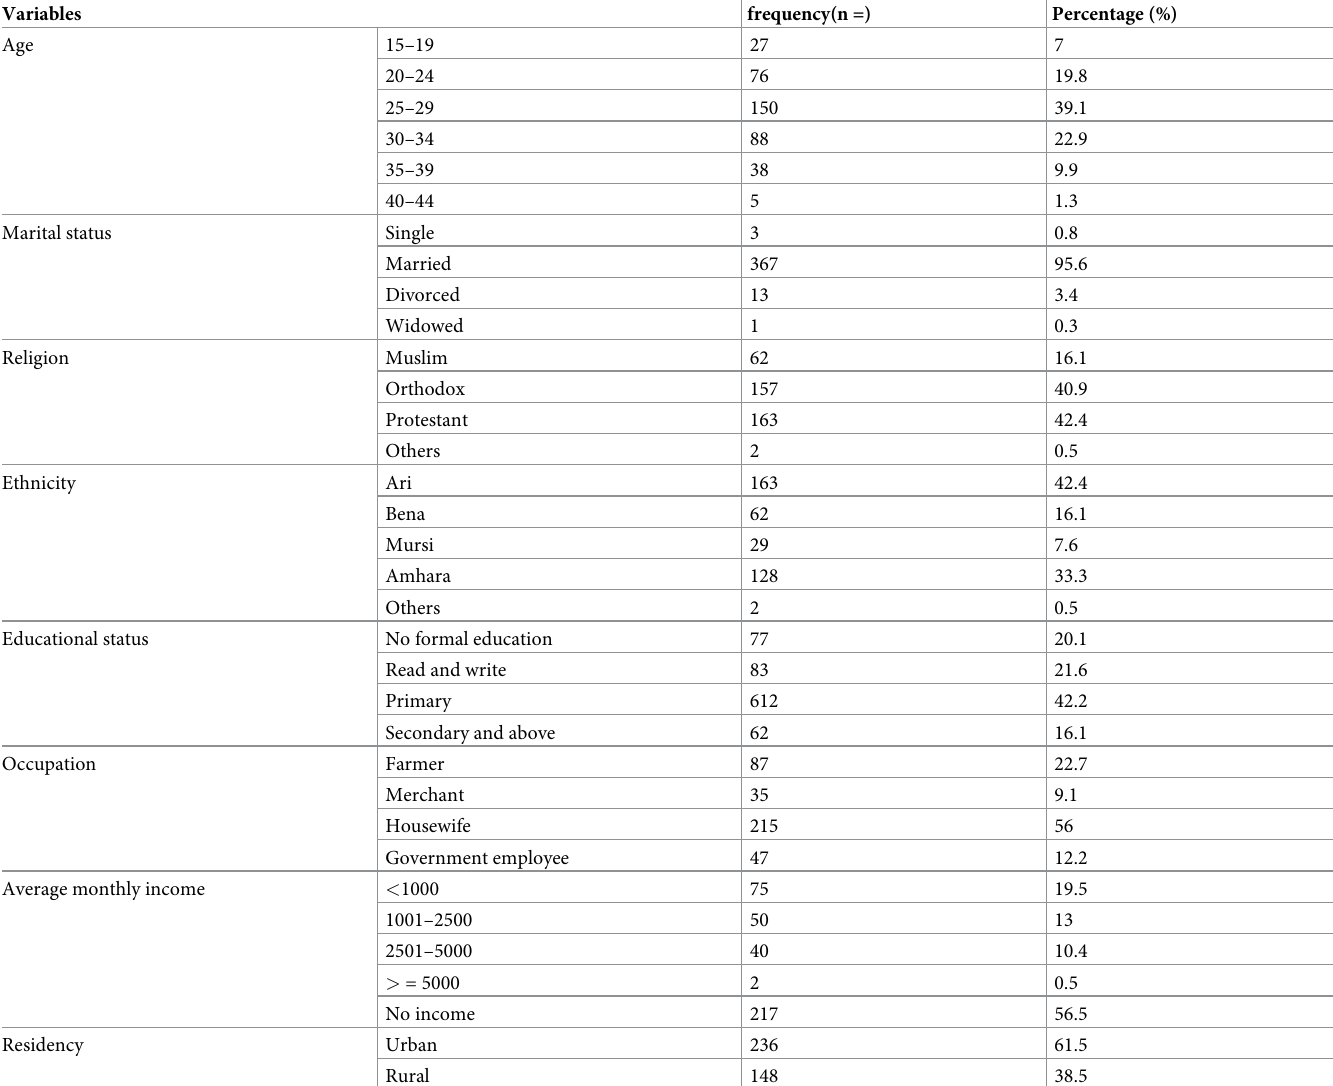
Table 1. Socio-demographic characteristics of pregnant mothers attending antenatal care at South Omo Zone hospitals, Southern Ethiopia,